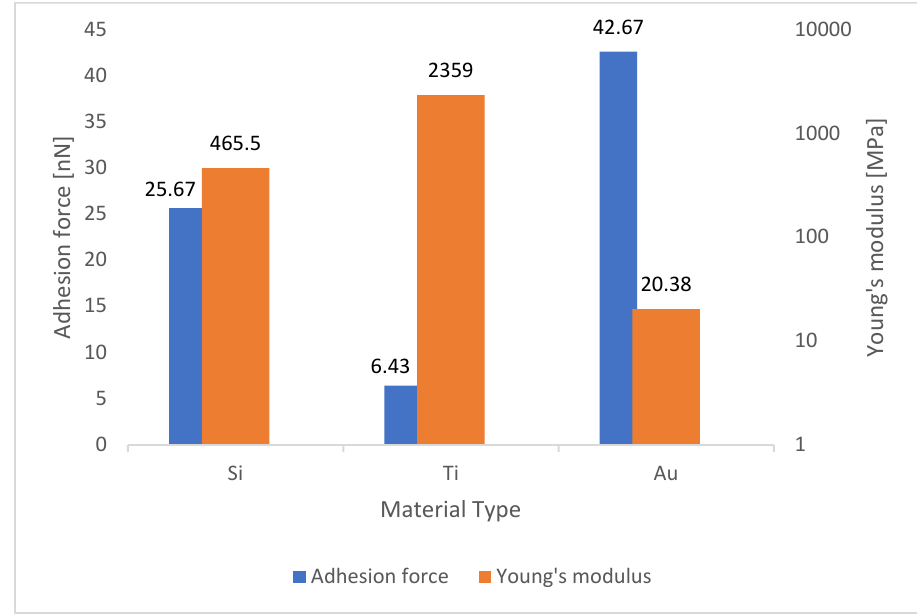
Figure 7. Comparison of values of Young’s modulus with adhesion force in the silicon surface.